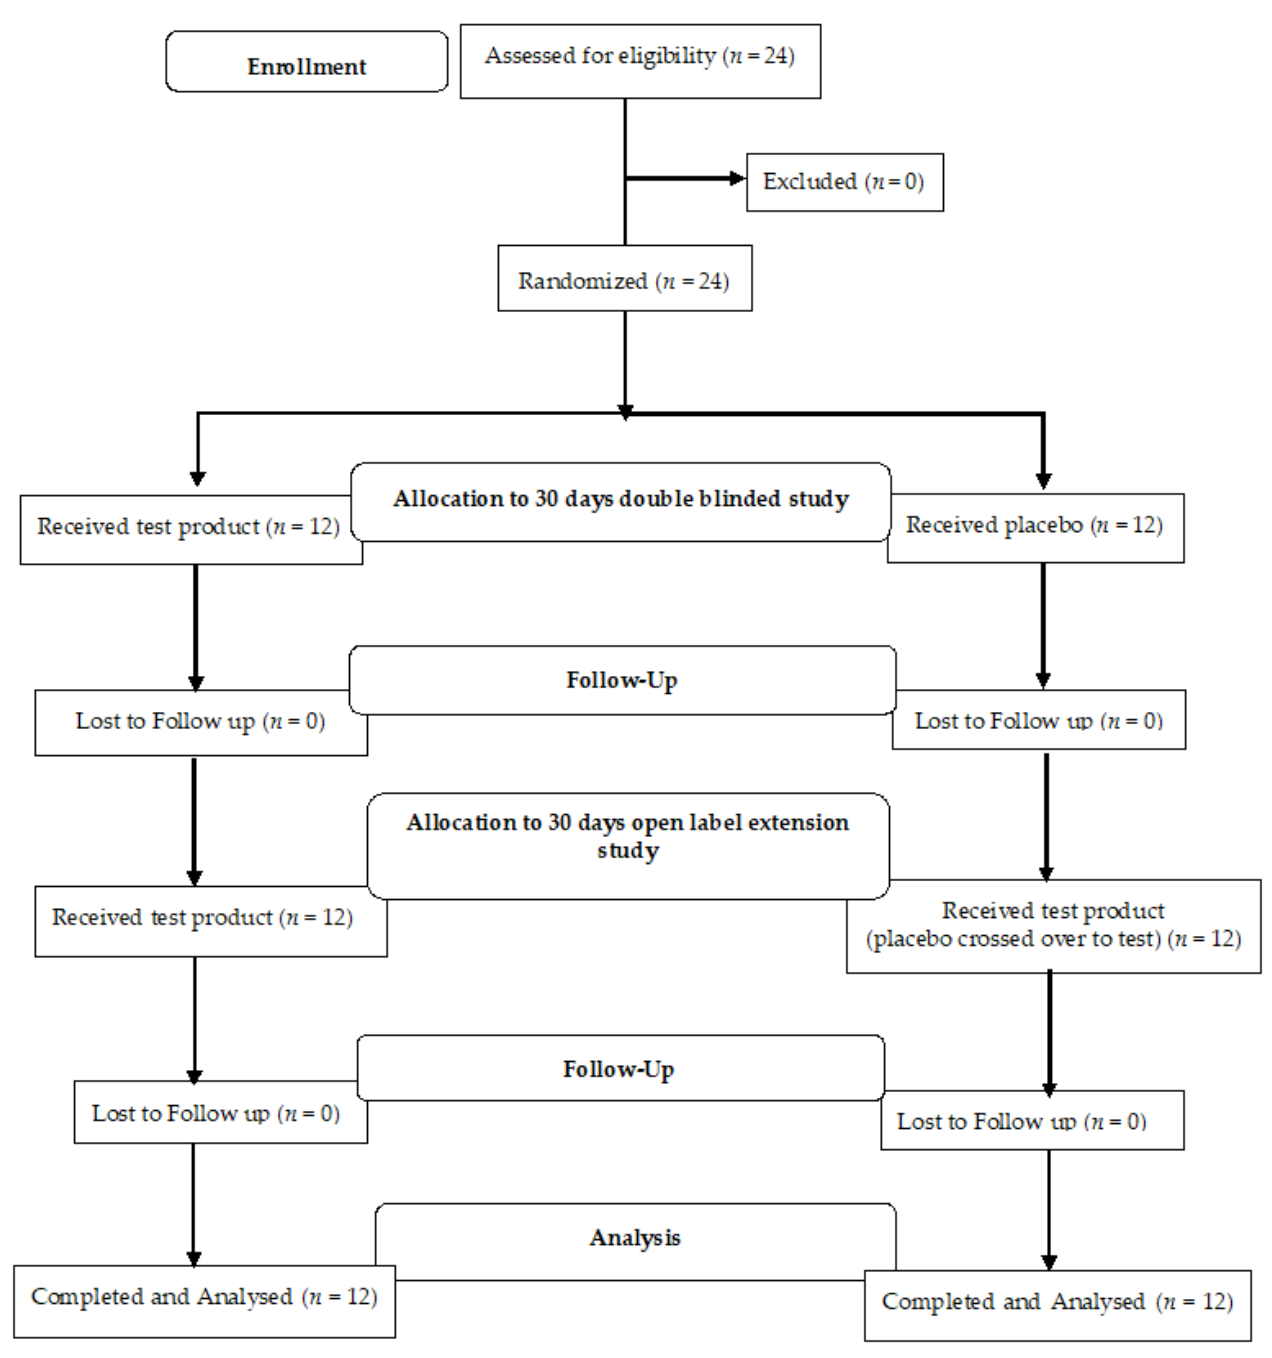
Figure 1. Participants flow diagram Table 1. Comparison of the baseline demographics of the test group and placebo group.